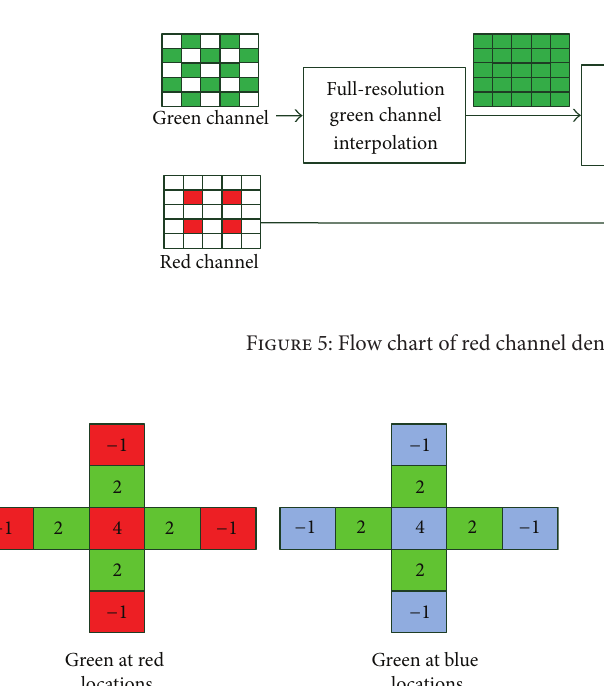
Green at red locations Figure 6: Filter coefficients for green